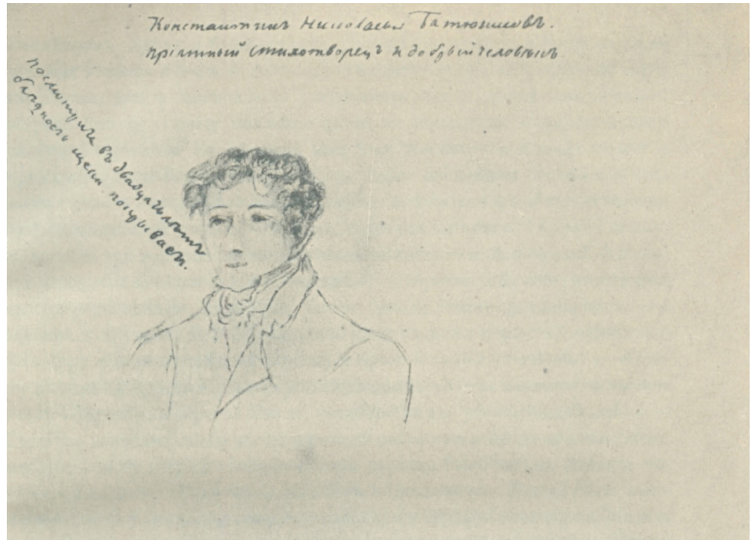
Figure 45. Konstantin Batiushkov. Self‑portrait, 1821. Manuscript Department of the Institute of Russian Literature (Pushkin House), Russian Academy of Sciences, Saint